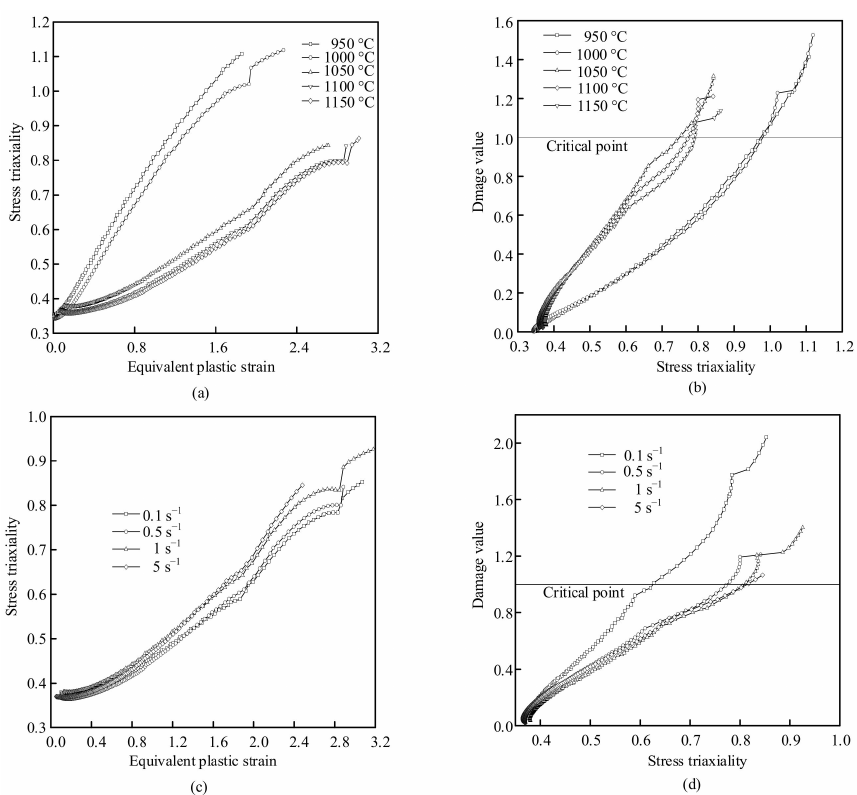
Figure 12. Stress triaxiality and damage changes under different deformation conditions: ( a ) Change of equivalent strain–stress triaxiality at 0.1 s − 1 , ( b ) Stress triaxiality-damage diagram at 0.1 s − 1 , ( c ) Equivalent strain–stress triaxiality at 1100 ◦ C, ( d ) Stress triaxiality-damage diagram at 1100 ◦